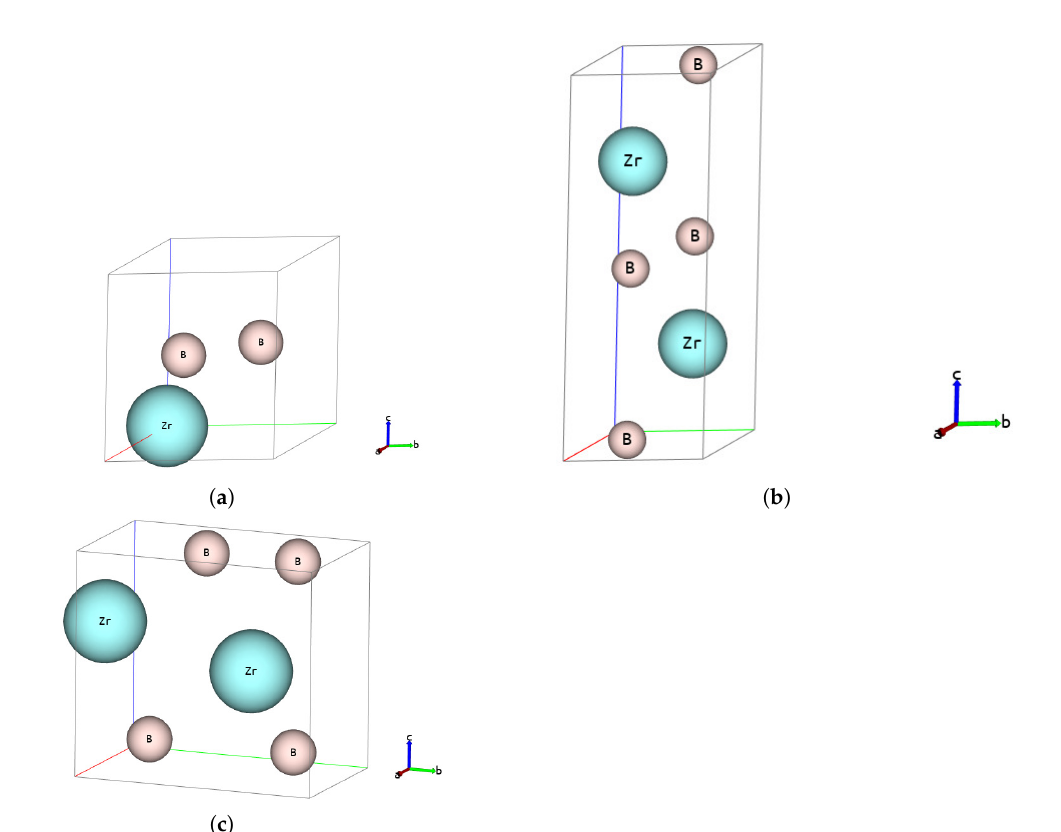
Figure 1. ZB 2 -Basic cells: ( a ) hP3 -P6/mmm, ( b ) hP6 -P6 3 /mmc and ( c ) oP6